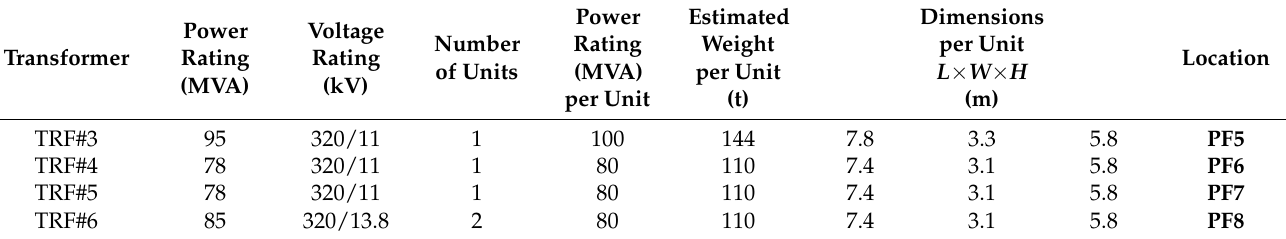
Table A4. Transformers design for Architecture 2.